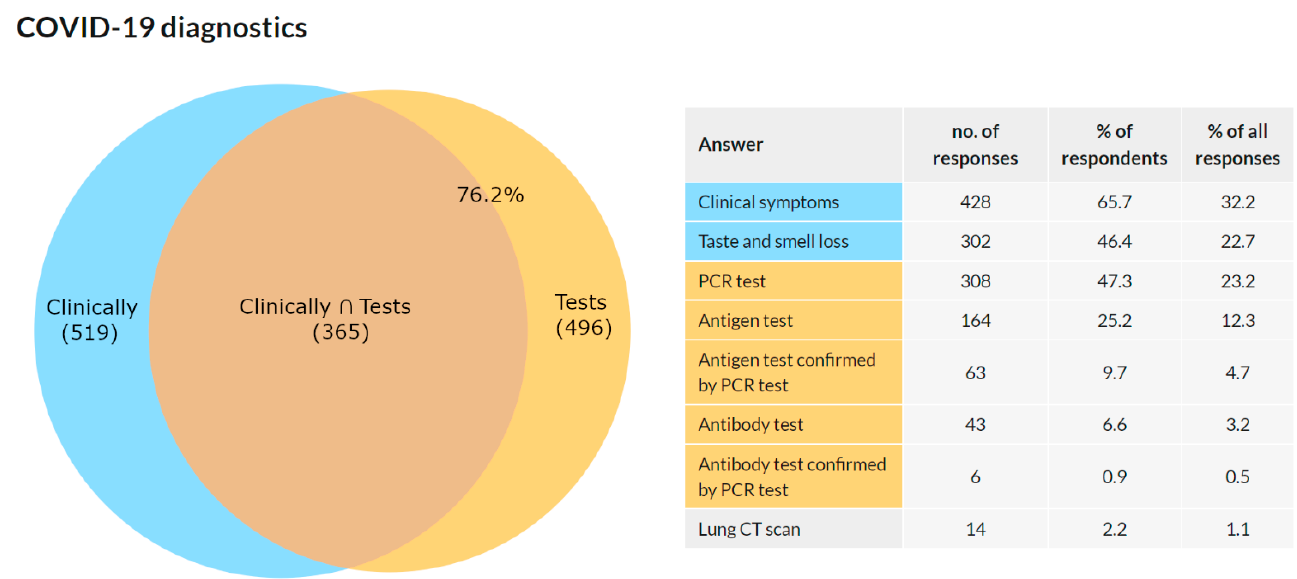
Figure 8. COVID-19 diagnostics.